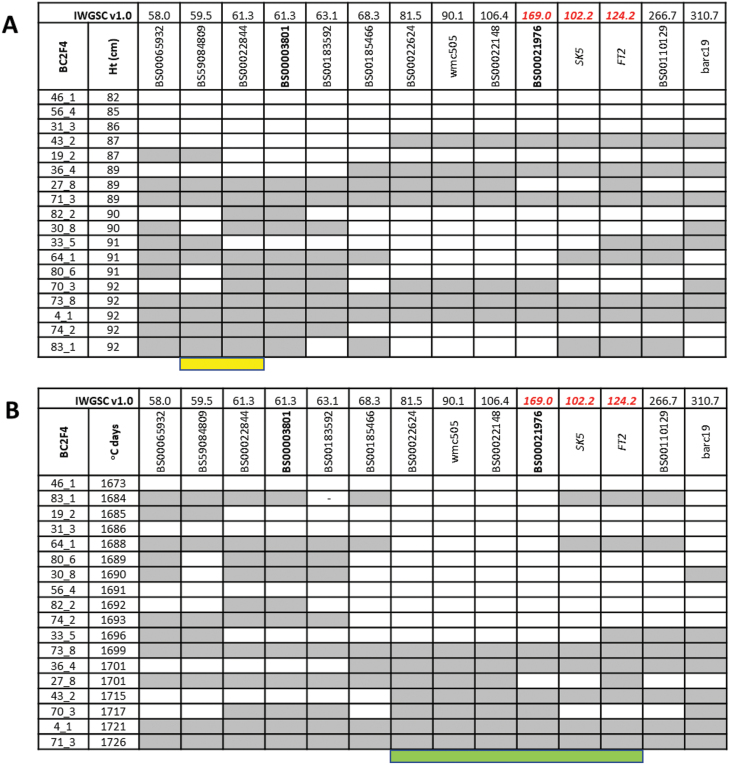
High-resolution genetic maps of the Ht and Hd QTL regions on chromosome 3A. The genotype for each marker and Ht or Hd data of 18 BC2F4 recombinants is shown. The top row of each figure shows the position of markers (second row) in the IWGSC RefSeq v1.0 (Mb). Positions in the RefSeq in red indicate a rearrngement relative to the Chinese Spring sequence. The peak QTL marker for each trait is shown in bold. Marker genotypes are shown in white (Avalon) or grey (Cadenza) in the recombinants. (A) The recombinants are ordered in increasing height (cm). Candidate genes for Ht would be in the region indicated in yellow. (B) The recombinants are ordered in increasing Hd (°C d). Candidate genes for Hd would be in the region indicated in green.